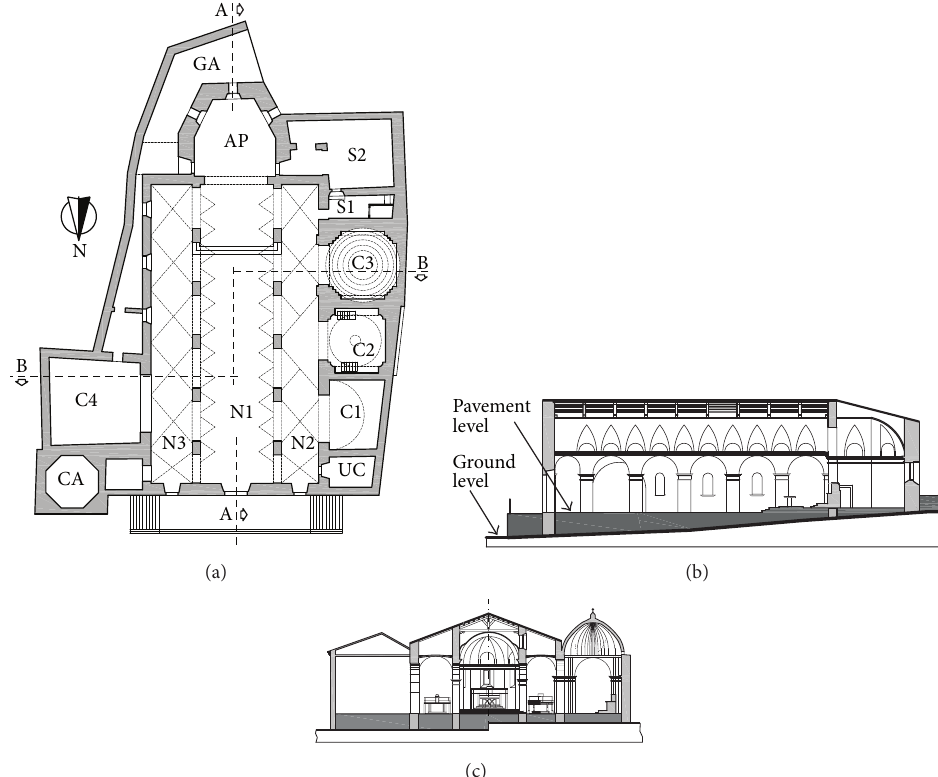
Figure 2: Madre Santa Maria del Borgo church, San Nicandro, Italy: (a) plan layout, (b) longitudinal section A-A, and (c) transversal section